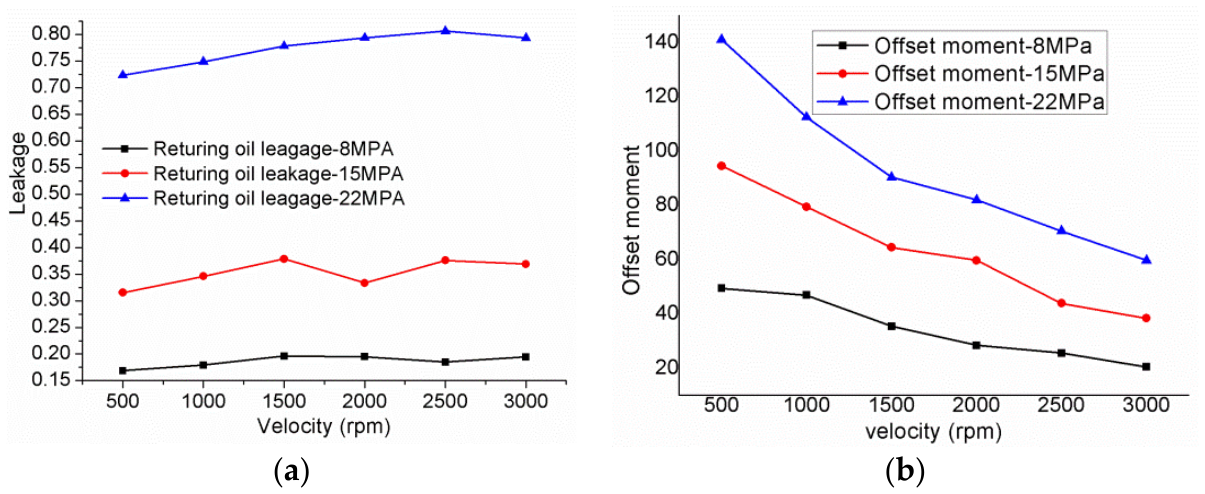
Figure 28. Experimental data of the leakage and torque. ( a ) The leakage quantity of the port plate pair changes with the speed of rotation; ( b ) the torque of the piston pump changes with the speed of rotation.